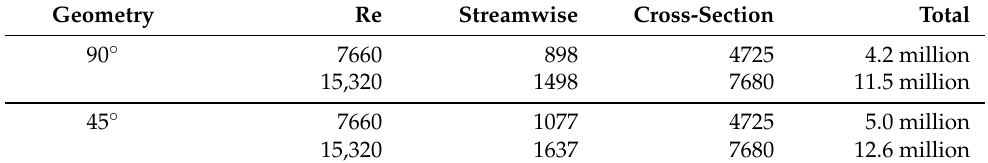
Table 1. Number of grid points of the block-structured grids used for LES of the bend flows. Geometry